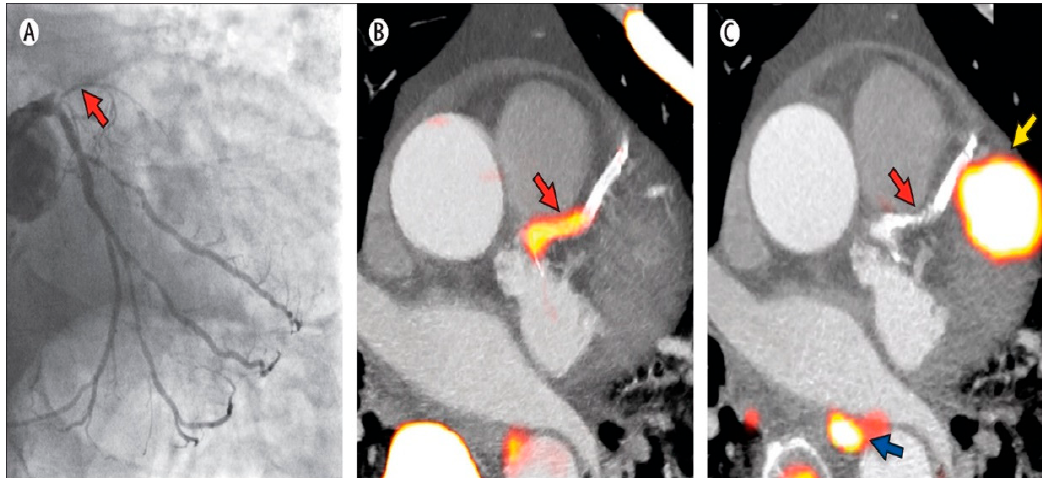
Figure 4. PET/CT imaging of 18 F-fluoride and 18 F-FDG uptake in a patient with acute myocardial infarction seen by ST-segment elevation on EKG. Invasive coronary angiography ( A ) demonstrates a proximal occlusion ( red arrow ) of the left anterior descending artery. 18 F-Fluoride PET/CT imaging ( B ) identifies the culprit plaque ( red arrow ) based on ( B ) intense focal uptake (yellow-red). The corresponding 18 F-FDG PET/CT image ( C ) shows no uptake at the site of the culprit. Significant uptake can be seen in myocardium next to the coronary artery ( yellow arrow ) and in the esophagus ( blue arrow ). Adapted from Joshi et al., 2014, by permission from The Lancet [55].